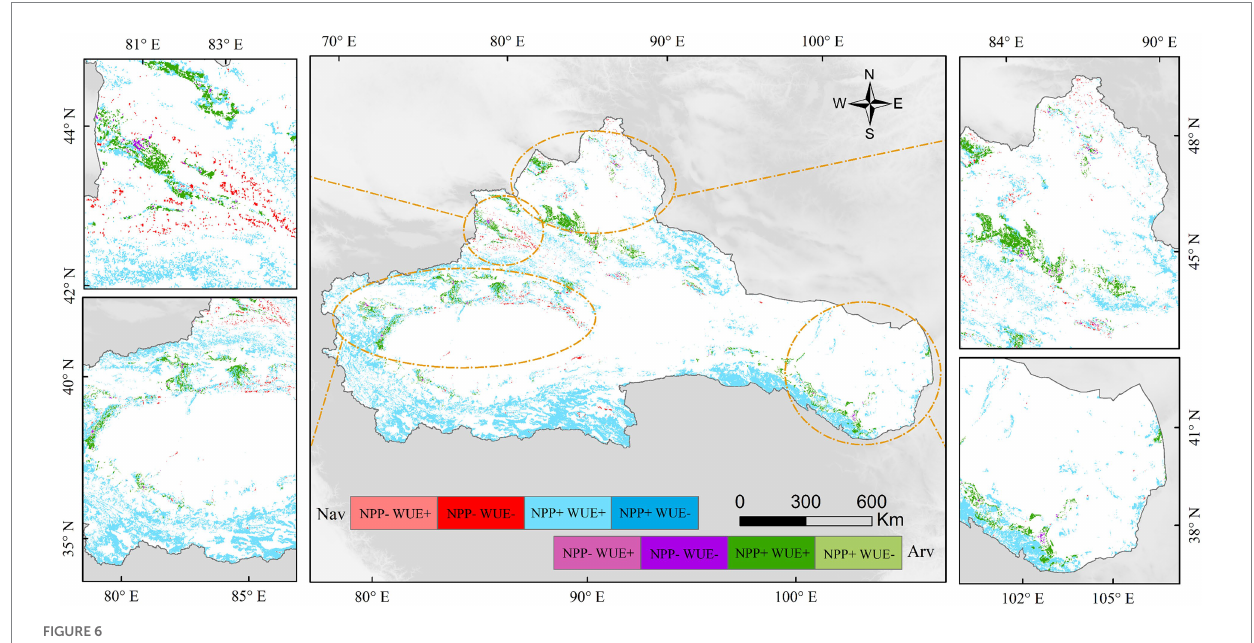
FIGURE 6 Spatial pattern of land degradation and restoration in the NAR.